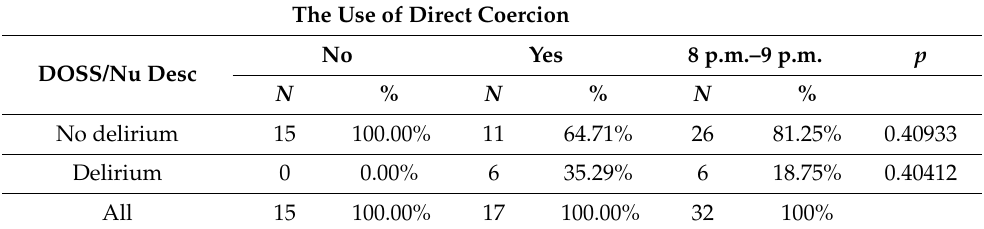
Table 3. Characteristics of delirium occurrence in groups of direct coercion.